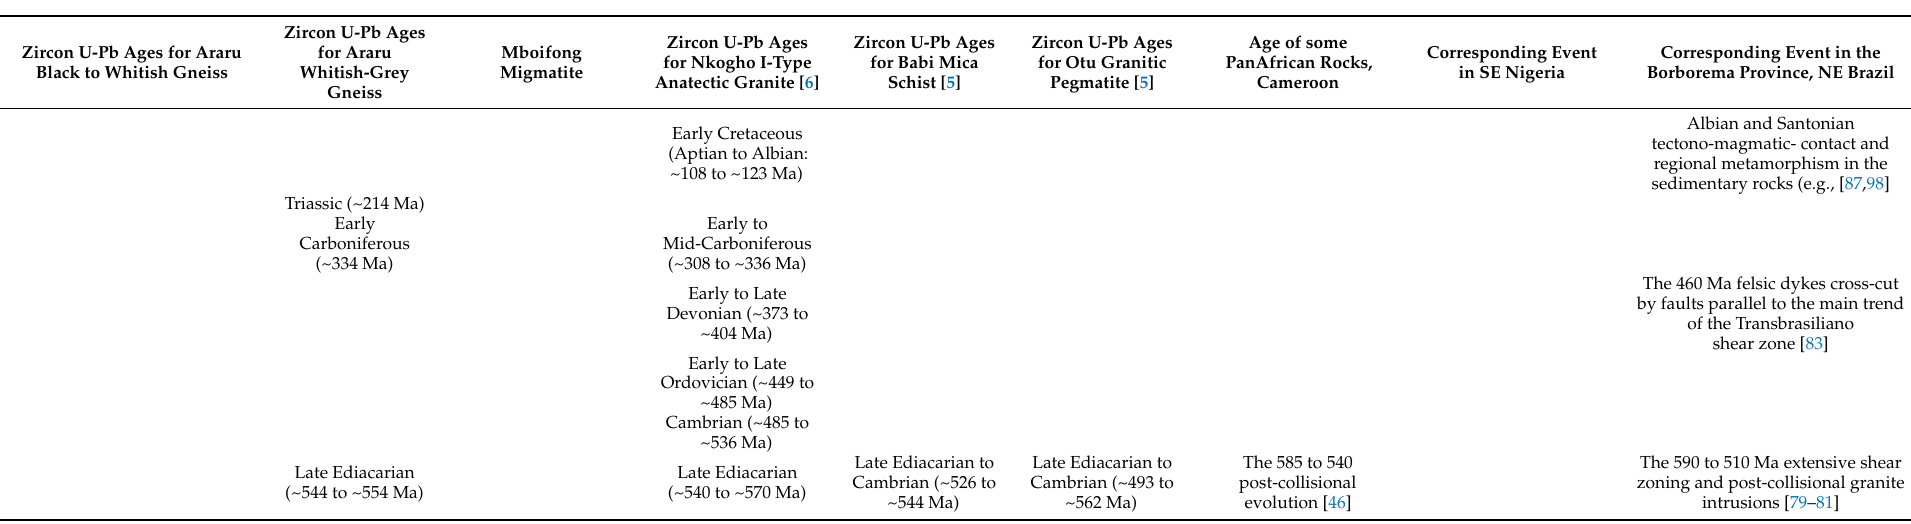
Table 5. Age correlations between zircons from Araru black to whitish gneiss, Araru whitish-grey gneiss, Mboifong migmatite, Otu granitic pegmatite; Babi mica schist, and Nkogho I-type anatectic granite and Nkogho I-type anatectic granite, rocks SW Cameroon mobile belt, basement rocks in SE Nigeria, and the Borborema Province in NE Brazil. Zircon U-Pb Ages for Araru Black to Whitish